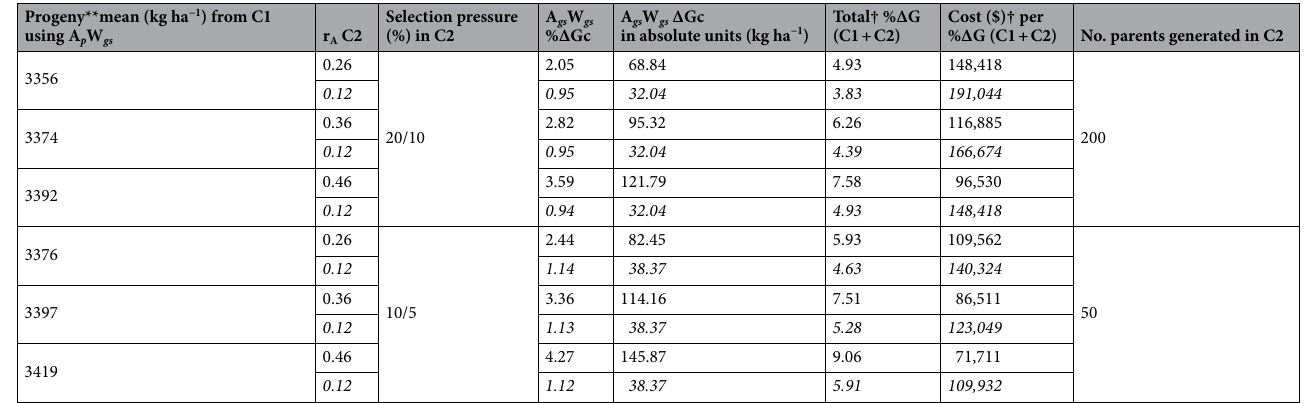
Table 4. Cycle 2 (C2) is based on selection among and within HS family progeny generated from polycrossing the elite parents identified in cycle 1. In C2, both among and within HS selection is based only on genomic selection (GS). Combinations of among and within ( among/within ) HS family selection at selection pressures of among/within, 20%/10% and 10%/5%, and different genomic prediction accuracies (r A ) were applied. From within each of 100 HS families generated from cycle 1 generated at 20%/10% and 10%/5% selection pressure, random samples of 100 seedlings per family were used in cycle 2, a total of 10,000 individuals subjected to GS. The costs per percent genetic gain (relative to the C1 HS family predicted progeny means), are based on $41 for generating a single GEBV (genomic estimated breeding value). The length of C2 is 1 year. percentage genetic gain per cycle of selection (%ΔGc), cost per percentage of predicted genetic gain ($ per % gain). r A, is the Pearson correlation coefficient between Phenotypic Estimated Breeding Values and GEBV’s, based on the predicted equation developed in C1. Among and within half-sib family genomic selection (A gs W gs ). In C2 an r A of 0.12, predicted in cycle 2 of stochastic simulation using Sim200 HS families, was used in deterministic simulation to model a possible scenario of r A decay, displayed in italics in the table. **, mean of 200 HS families plus predicted ΔG in C1; †, sum of gain (%ΔGc) and cost ($) from C1and